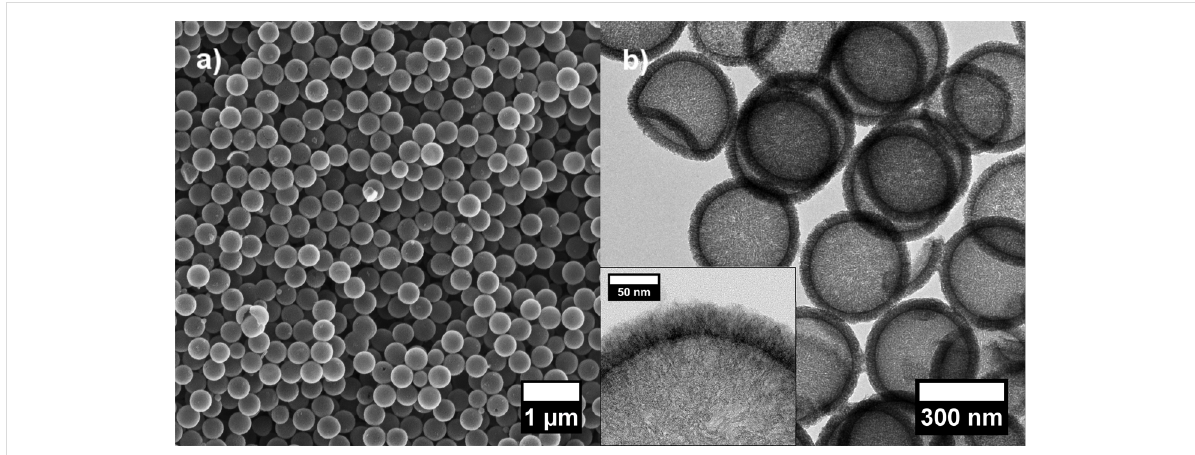
Figure 2: a) SEM and b) TEM images of mesoporous hollow carbon spheres. Inset: larger magnification of the shell of a hollow sphere.